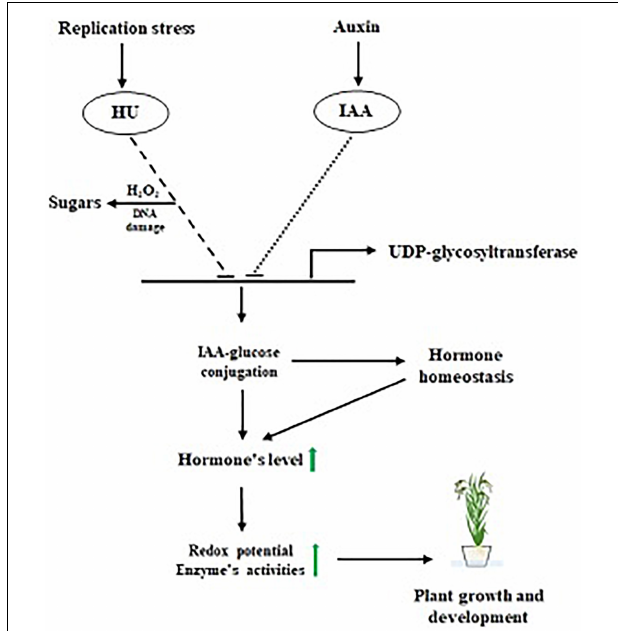
FIGURE 9 | Proposed model for IAA-glucose mediated hormone